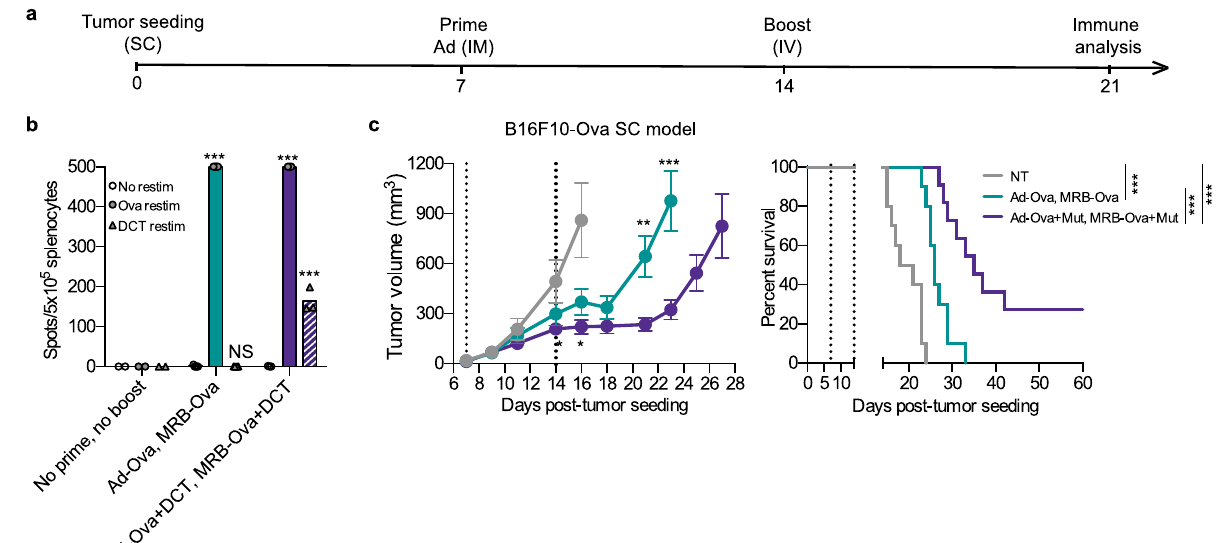
Fig. 7 OVs encoding antigens can be used as platforms for personalized vaccines. a Treatment schedule used in this study. b IFN γ ELISPOT analysis of splenocytes from mice primed with Ad-Ova ± DCT peptide and boosted with MRB-Ova ± DCT peptide (from left to right; n = 2, 5 and 3). The statistical analyses refer to the comparison between the corresponding ex-vivo “ No restim ” and “ restim ” conditions. NS: p > 0.05, ***: p < 0.001 (unpaired multiple two-tailed t -test). c Tumor growth and survival analyses of mice bearing established SC B16F10-Ova tumors treated with Ad-Ova and MRB-Ova together or not with B16Mut20, B16Mut30, B16Mut44 and B16Mut48 ( n = 10). Data are presented as mean values ± SEM. *: p < 0.05, ***: p < 0.001 (unpaired multiple two-tailed t -test). Kaplan – Meier survival analysis: ***: p < 0.001 (Mantel – Cox test, two-sided). Source data are provided as a Source Data fi le. Exact p values can be found in the Source